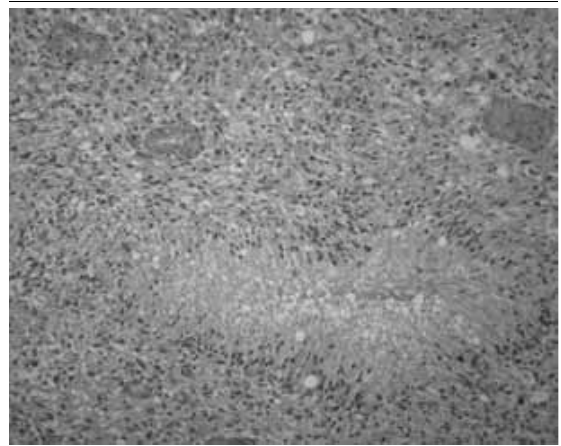
figurE 3 – A classic pattern of GBM: palisading around zones of necrosis. HE, 100× GBM: glioblastoma; HE: hematoxylin and eosin.